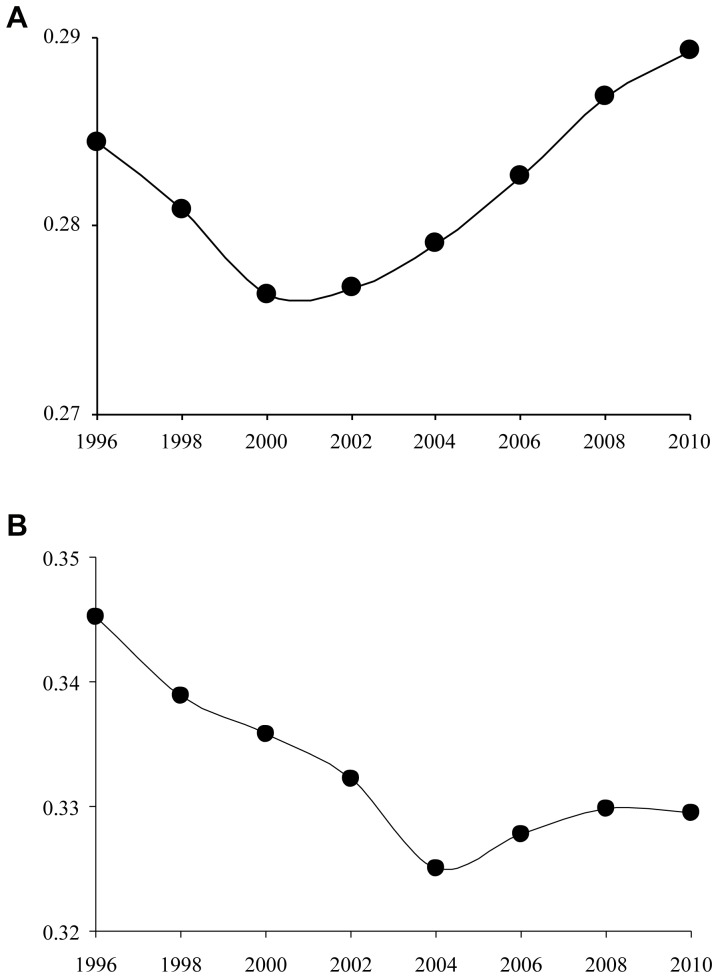

Figure 1-a; Mean of Gini coefficient of all physicians in intra-prefectural distributions.
Figure 1-b; Mean of Gini coefficient of pediatricians in intra-prefectural distributions.